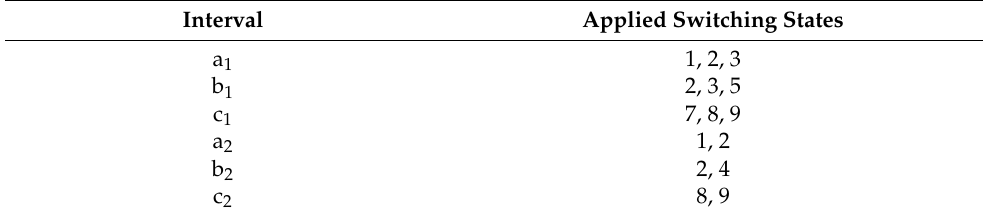
Figure 6. Simulation results for fault-tolerant operation of the inverter in the case of a short-circuit fault event in S13. Table 6. Applied switching states corresponding to each interval in Figures